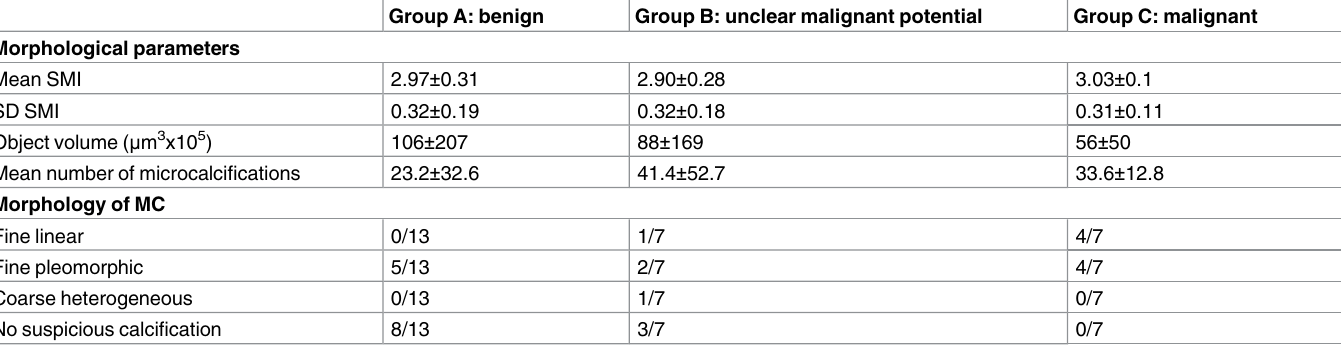
Table 3. Overview of the results of different morphological parameters including mean SMI, SD SMI, mean number of calcifications, the object vol- ume for histologically proven benign, malignant and unclear biological potential lesions. Moreoverthe presenceof the morphologicalMC types in the different groupsis